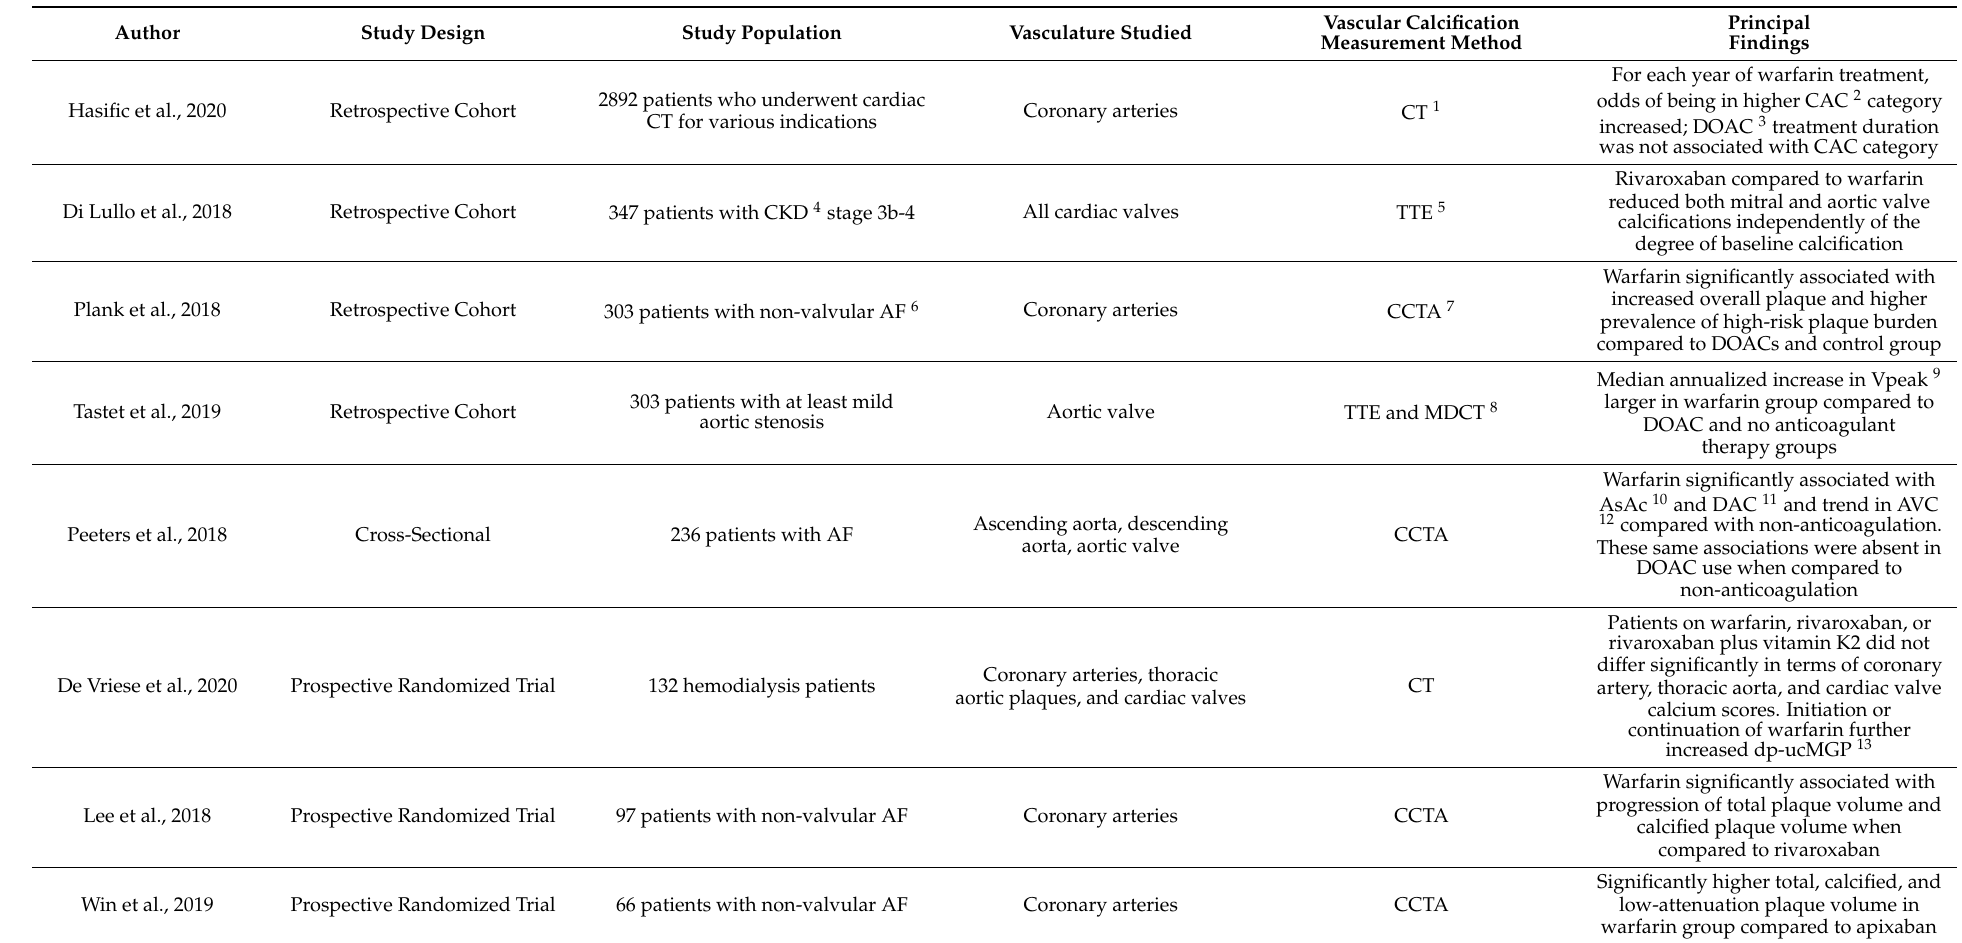
Table 1. Effects of warfarin vs. DOACs on vascular